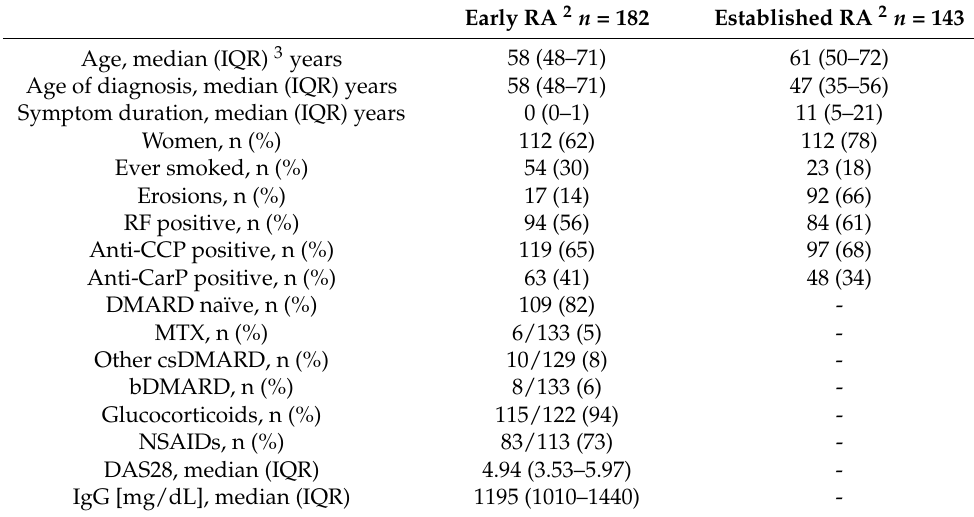
Table 1. Clinical characteristics of the two subsets of patients included in the present study 1 .